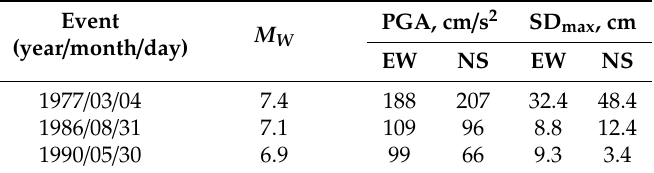
Table 2. Magnitude scaling of displacement spectra, INCERC